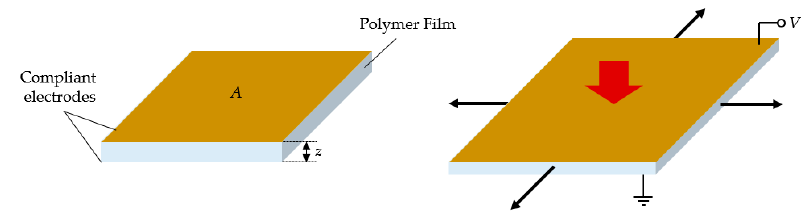
Figure 1. The dielectric elastomer (DE) operation principle by electrostatic forces.